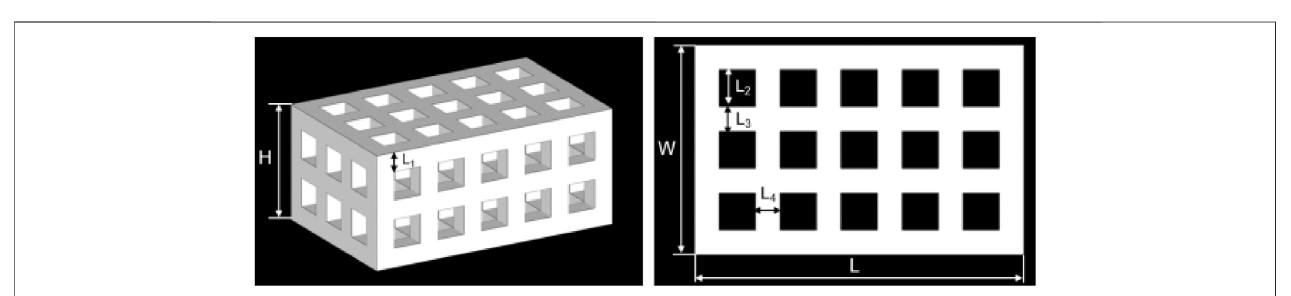
FIGURE 2 | The 3D model of the porous scaffold for SLS.